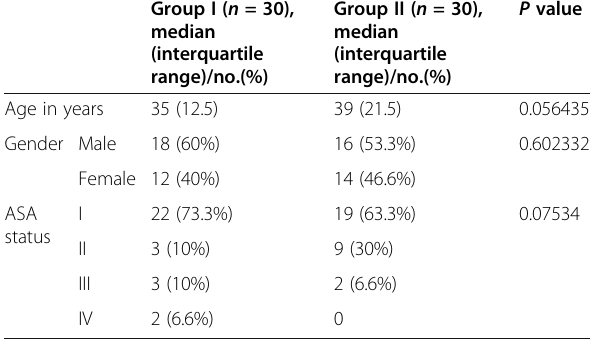
Table 1 Demographic data among the two groups